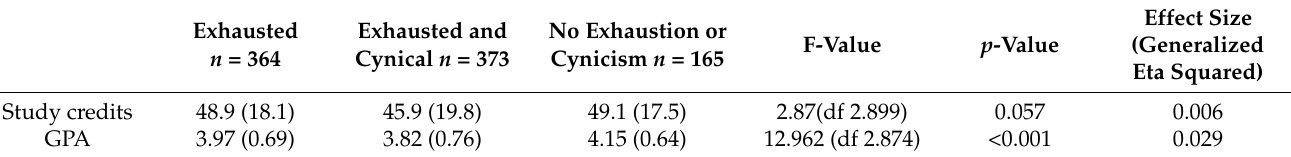
Table 2. Study credits and GPAs (grade point averages) across profiles.